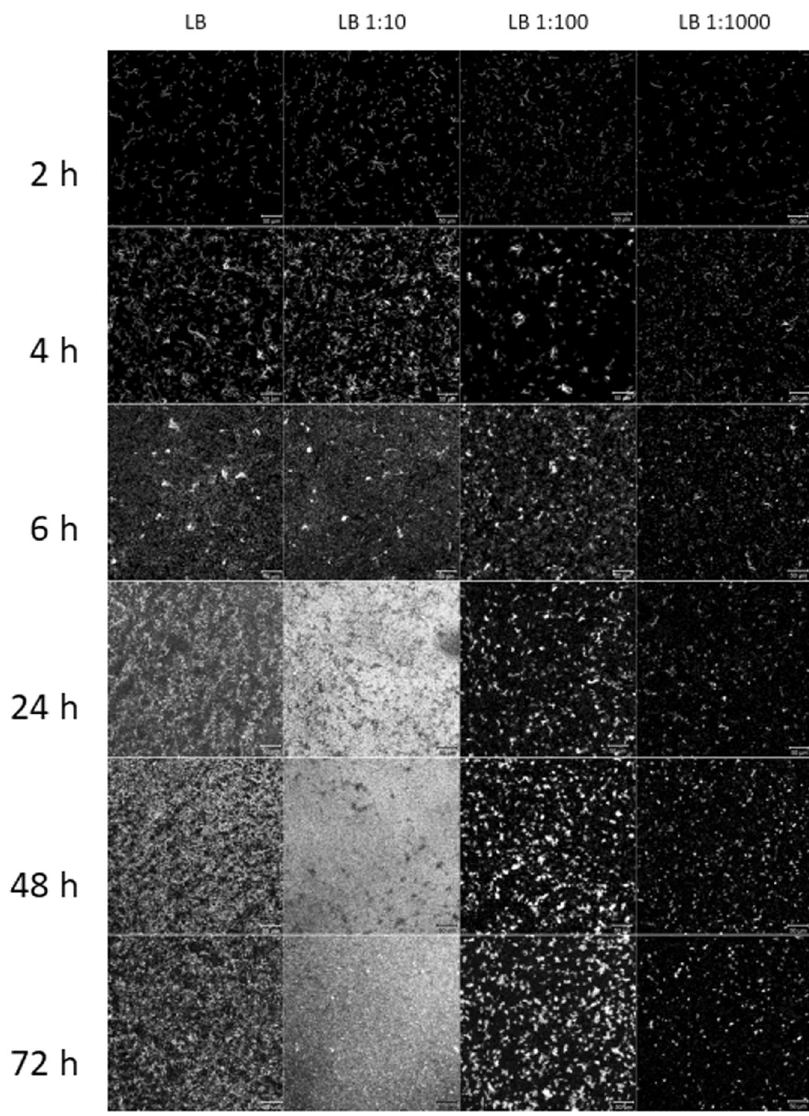
Fig. 3 In fl uence of nutrient supply on bio fi lm formation of P. fl uorescens during 72